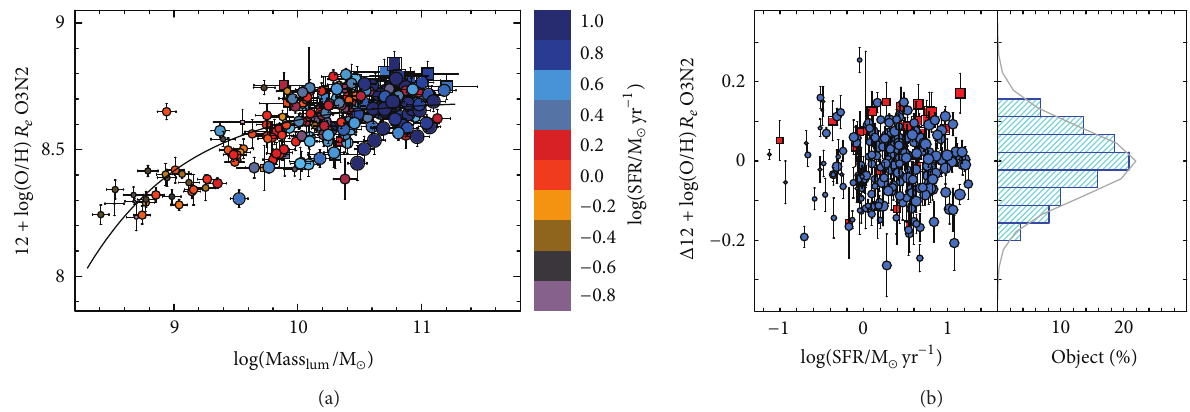
Figure 6: (a) Distribution of the oxygen abundances at the effective radii as a function of the integrated stellar masses for the CALIFA galaxies(193,circles).Forcomparisonpurposes,weshowsimilarvaluesforthegalaxiesobservedintheCALIFAfeasibilitystudies(31,squares) included in the Hii regions catalog described in S´anchez et al. [14]. The size of the symbols is proportional to the integrated SFR. The solid line represents the best-fitting curve, as described in Sanchez et al. [35]. The colors represent the logarithm of the integrated SFR for each galaxy. (b) Distribution of the differential oxygen abundances with respect to the solid-line shown in (a) (i.e., the dependence on the stellar mass), as a function of the integrated SFR for the CALIFA galaxies (113, blue solid circles). The size of the symbols is proportional to the oxygen abundances shown in Figure 6. The histogram shows the same distribution of differential oxygen abundances. The solid line represents a Gaussian function with the same central value (0.01dex) and standard deviation (0.07 dex) as the represented distribution, scaled to match the